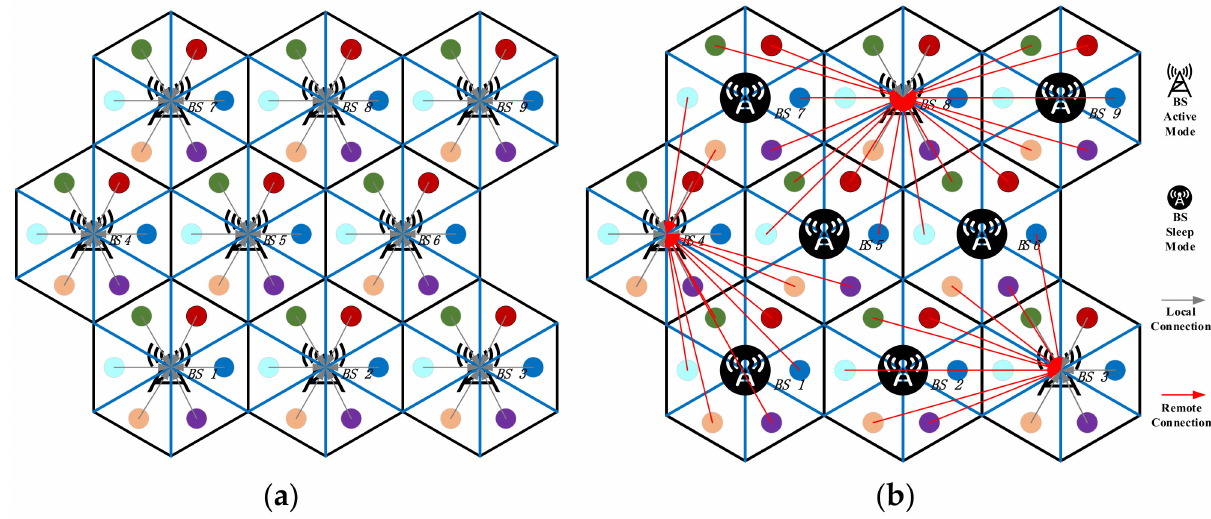
Figure 7. On/off states of BSs and cluster association strategy: ( a ) peak period of traffic load and ( b ) valley period of traffic